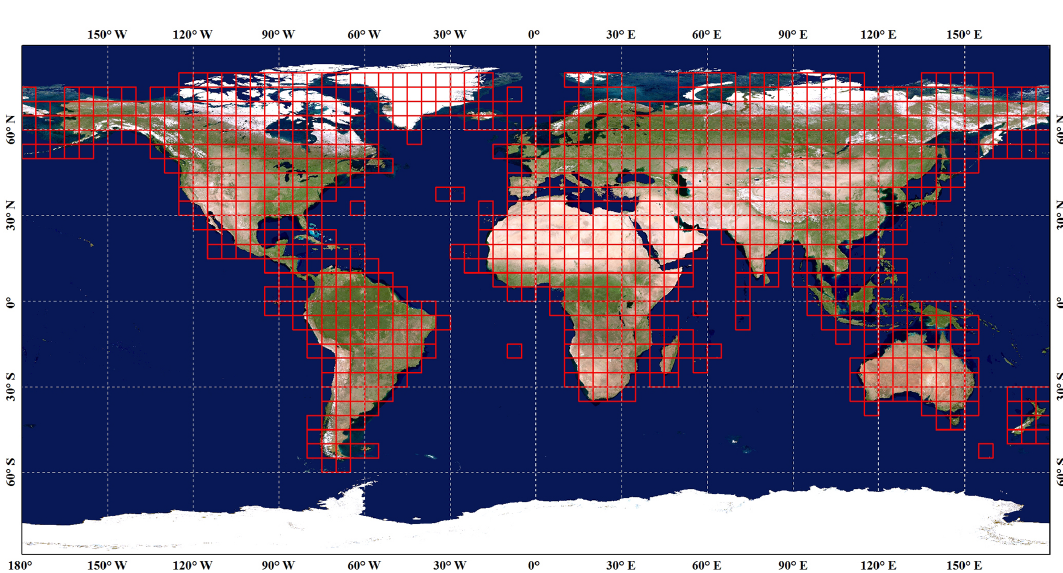
Figure 5. The spatial distribution of 961 5 ◦ × 5 ◦ geographical tiles used for local adaptive modeling, which was inherited from the global 30m land-cover mapping by Zhang et al. (2021b). The background imagery came from the National Aeronautics and Space Administration (https://visibleearth.nasa.gov, last access: 10 November